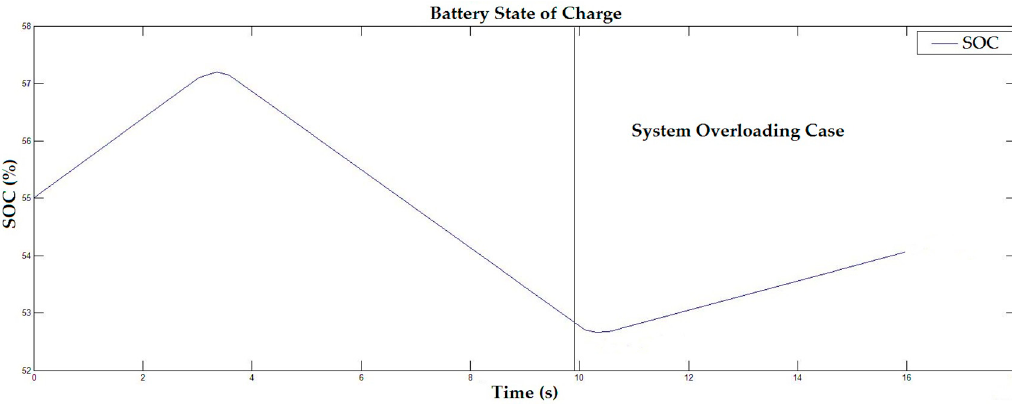
Figure 20 . Battery SOC in system overloading mode.